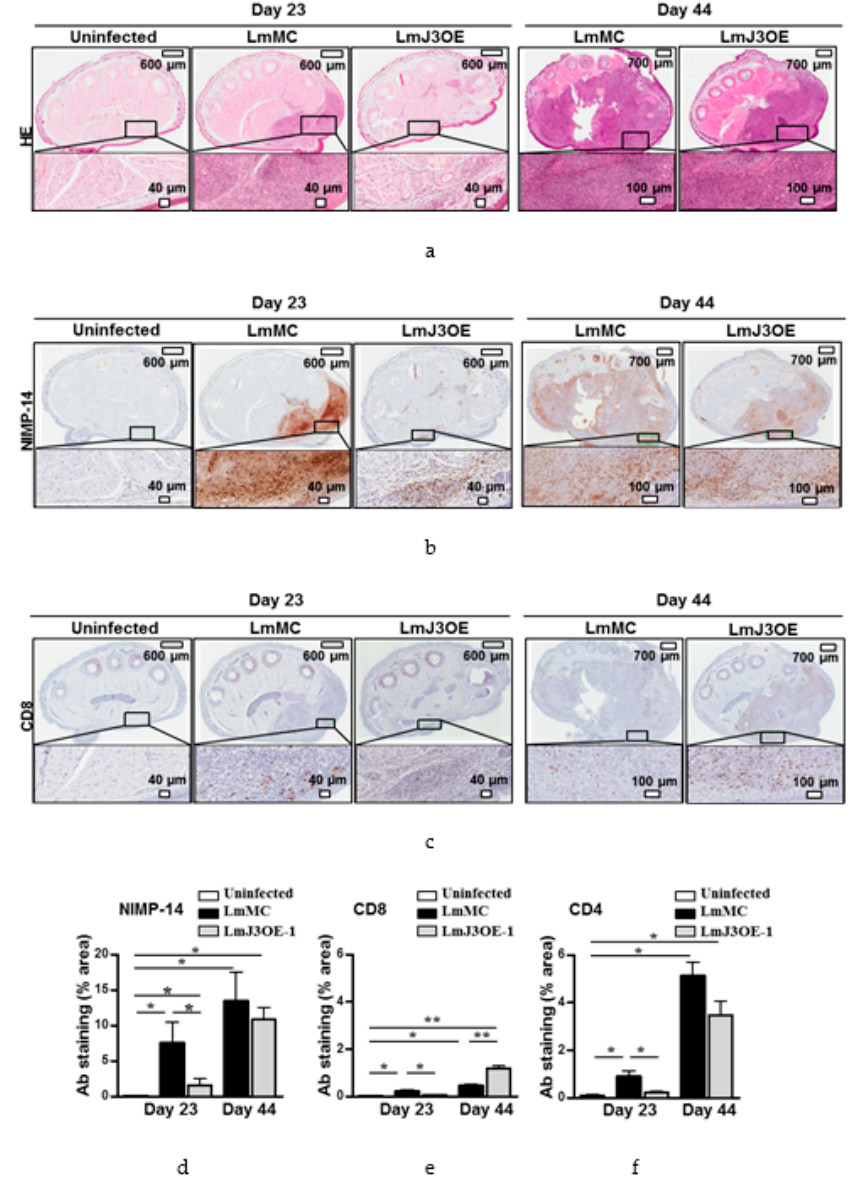
Figure 4. Histopathology and immunohistochemistry results of the footpad sections. Twenty-three and 44 days after the inoculation period, animals were sacrificed in order to study footpad inflammation by histology staining techniques. ( a ) Hematoxylin–eosin and ( b ) immunohistochemical staining for neutrophils (NIMP-14) and ( c ) CD8 T-cells of footpad sections of L. major -overexpressing LmjF.22.0810 (LmJ3OE-1)-infected mice compared to L. major control (LmMC)-infected mice, both 23 and 44 days after the last inoculation. ( d ) Graphical representation of the footpad section area stained with NIMP-14 (neutrophils), as well as ( e ) CD8 and ( f ) CD4 T cell antibodies of LmJ3OE-infected mice compared to uninfected and LmMC-infected. Bars represent the means (± SD) (* p < 0.05, ** p < 0.01). The expression of LmjF.22.0810 assessed at these time points confirmed the overexpression of